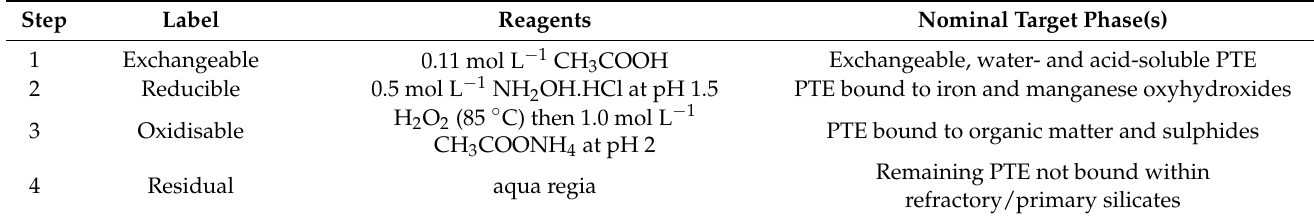
Table 1. BCR sequential extraction